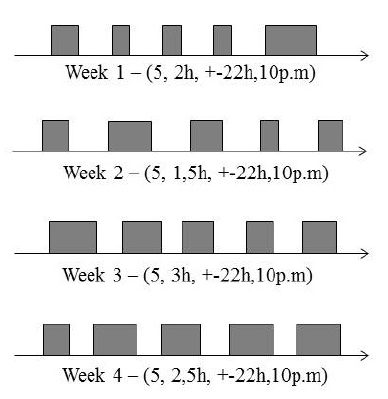
Figure 2. History of encounters between nodes 13 and 22 in the Sassy Scenario. According